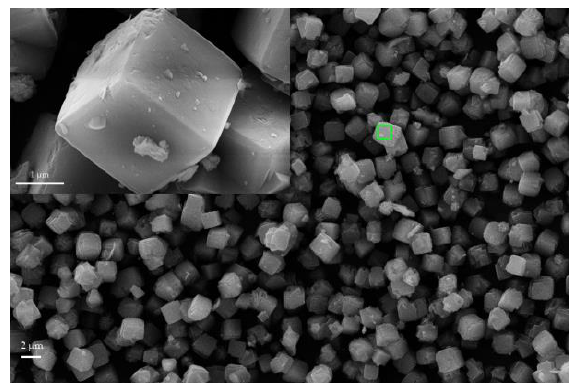
Figure 7. Scanning electron microscope (SEM) image of No. 20.